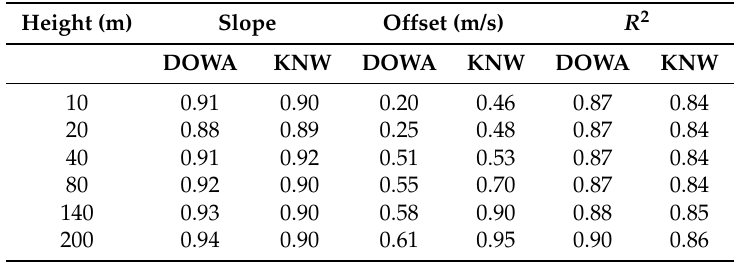
Table 1. Results of the linear regression fit in terms of the slope, offset and R 2 parameters, comparing DOWA and